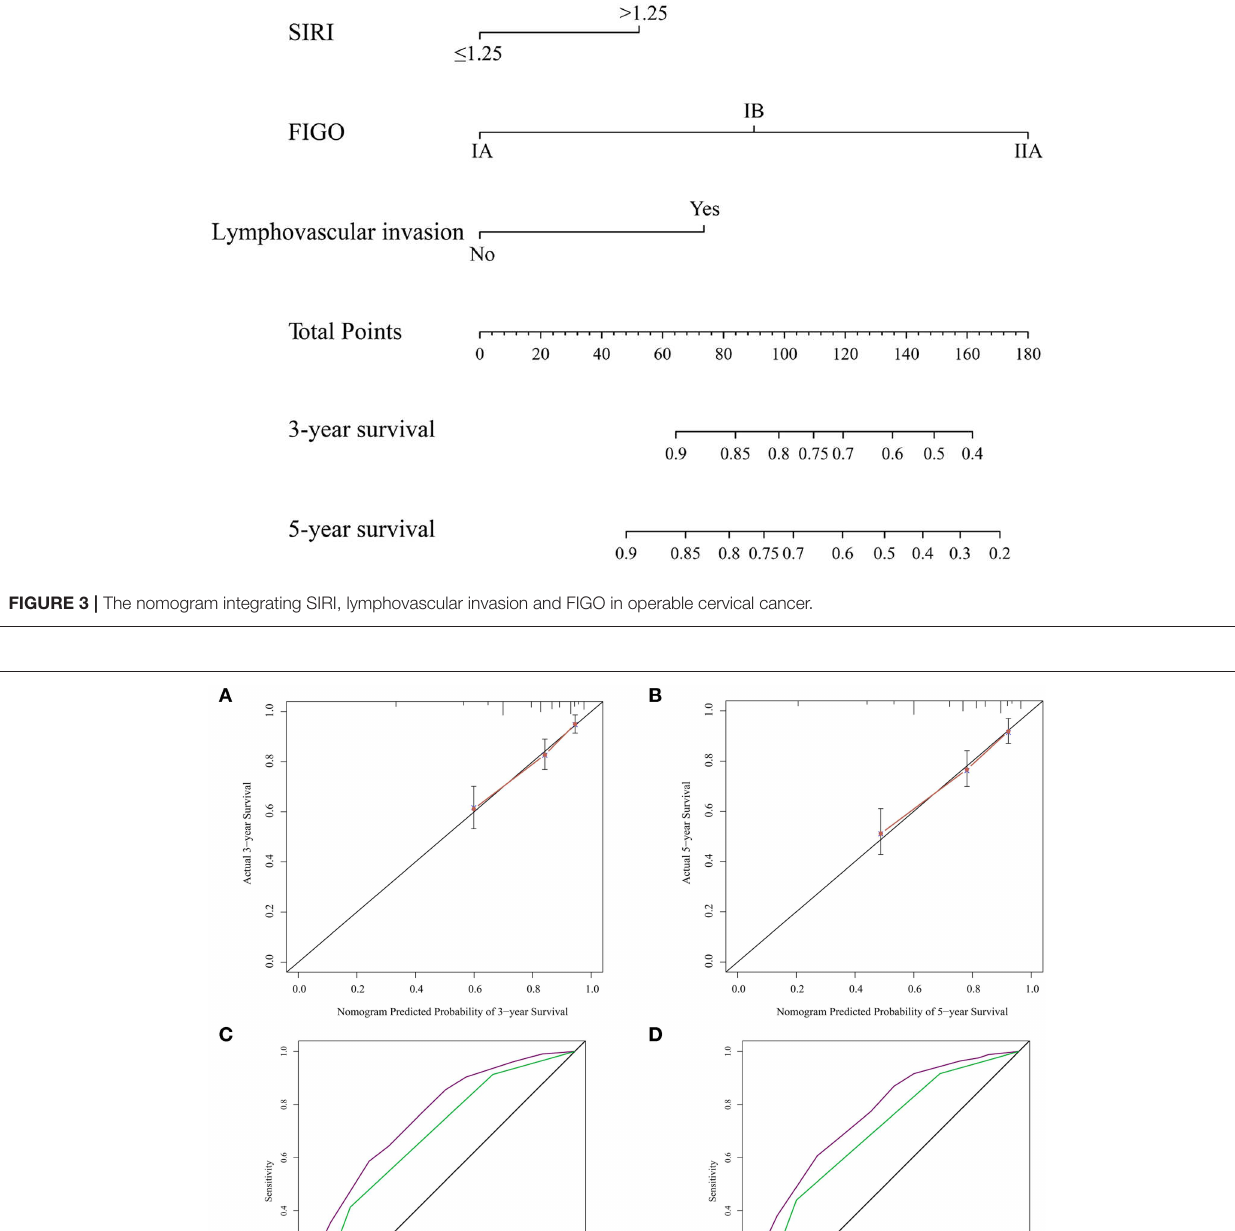
Frontiers in Oncology | www.frontiersin.org